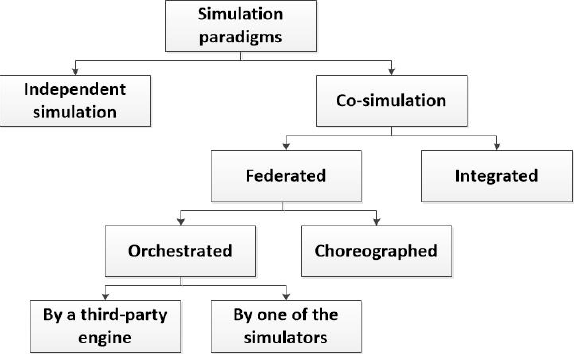
Figure 3. Taxonomy of CPSS simulation paradigms.